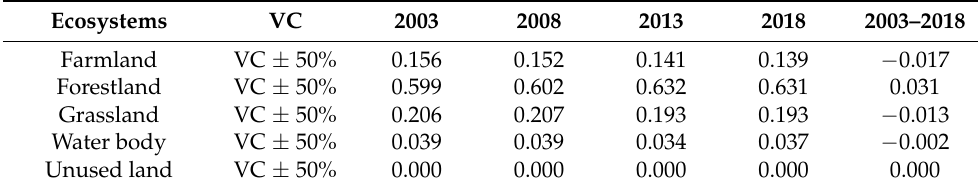
Table 2. Sensitivity index of ecosystem service value in